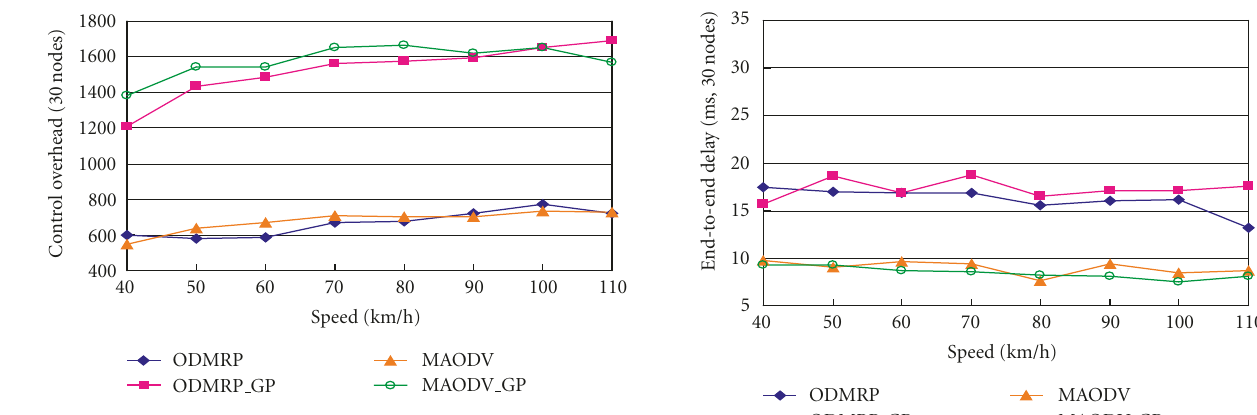
Figure 19: Control overhead versus mobility speed (30 nodes).